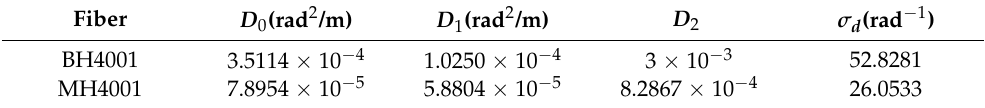
Table 2. Parameters for the fit of the sigmoid diffusion function for the BH4001 and MH4001 fibers.